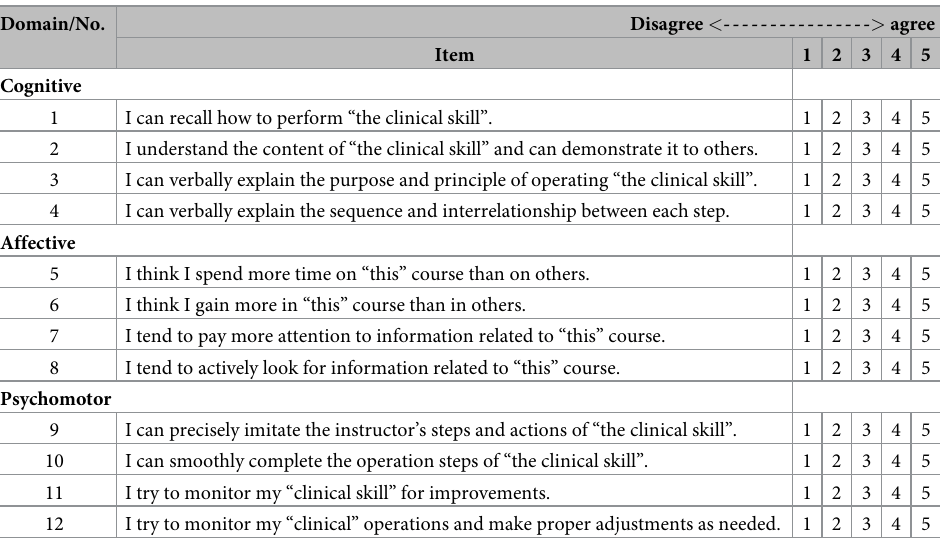
Table 5. The final version of the L-SES. Domain/No.